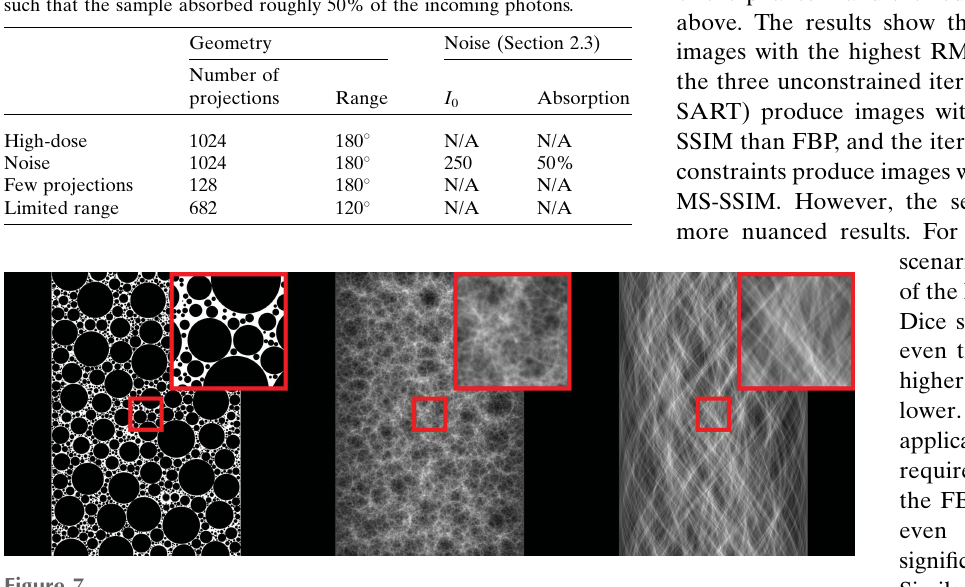
Table 1 Details of the projection datasets used for comparing reconstruction algorithms.